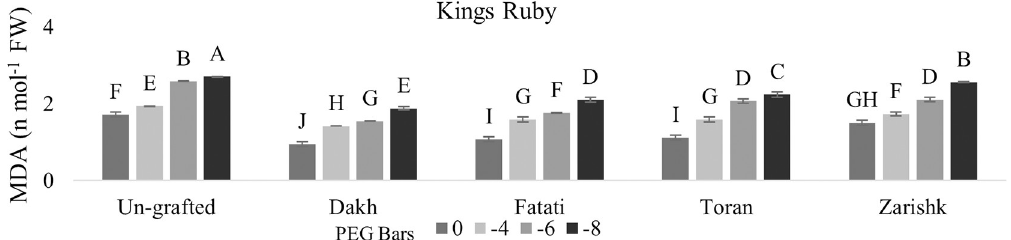
Fig 3. Malonaldehyde content (MDA) of un-grafted and grafted Kings Ruby scion variety on different wild grapevines under drought stress condition. Data is represented as mean SD and letters showed significant difference at p < 0.05.